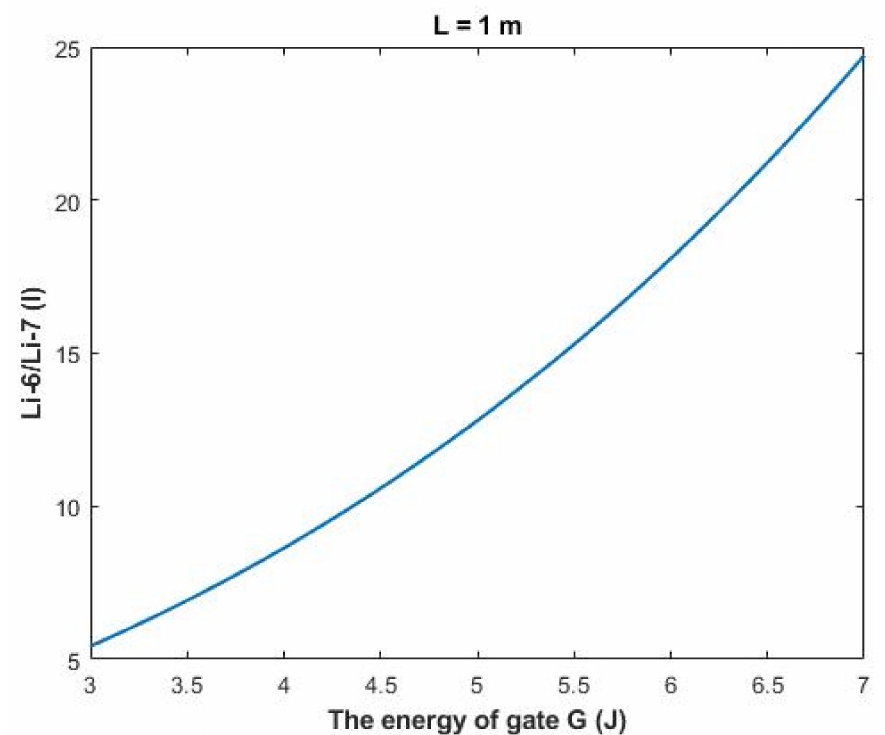
Figure 15. The figure represents the relationship between the ratio of the intracellular lithium isotopes Li-6/Li-7 (I) and the energy of gate G when setting L = 1 m.